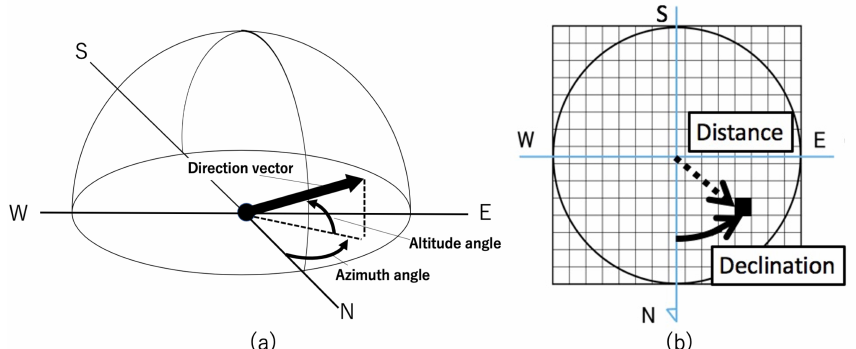
Figure 4. Conceptual diagram of SCS computation. SCS indicates the proportion of diffuse solar irradiance that is shielded by other voxels. ( a ) Determine a directional vector from the viewpoint voxel and generate a cylinder in that direction. ( b ) According to the discriminant shown in Equation (4), it is determined whether that direction is shielded by other voxels or not. The result was projected onto the image. The pixel value was zero or one, which means be unshielded or shielded, respectively. The distance from the center of the image and the declination angle correspond to the altitude angle and horizontal angle in ( a